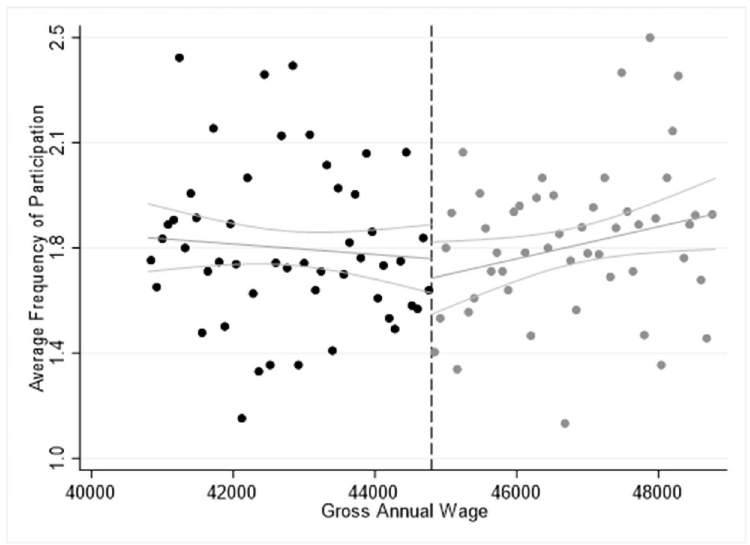
Fig 6. Sharp RDD estimates for participation in practising artistic activities using the salary threshold of 44,800 € and 2011 as the “Placebo” implementation year of the EU Blue Card programme.